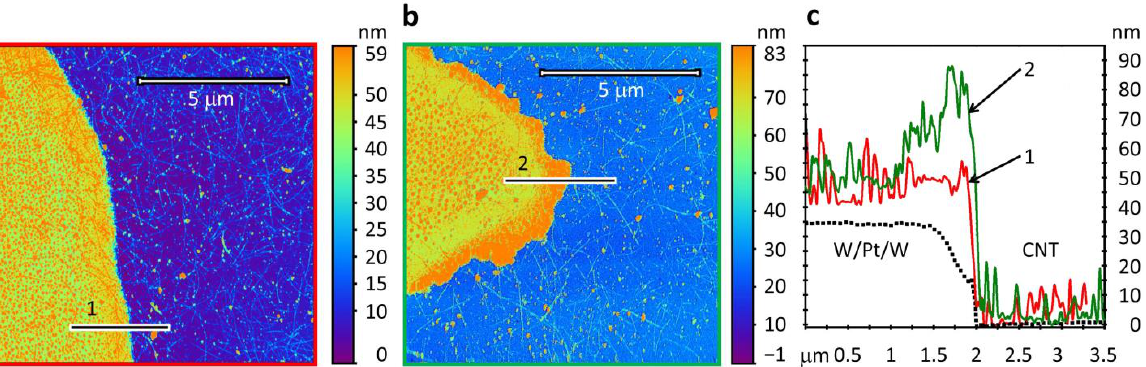
Figure 3. The exploring of sensor structures under study with atomic force microscopy: ( a ) AFM image of SWCNT-Pt structure (SWCNT50-Pt); ( b ) AFM image of SWCNT-WO 3 structure (SWCNT40-WO 3 ); ( c ) cross-sections of edge of initial metal W/Pt/W area and of “1”, “2” lines marked at 1a,b corresponding to profiles of SWCNT50-Pt and SWCNT40-WO 3 structures. sSWCNT50, sample. The appearance of WO 3 with crystalline structure was indexed by measuring the Raman spectra via recording the corresponding peaks at 265 cm −1 , 705 cm −1 , and 805 cm −1 [40,41], as shown in Figure 4a,b. Figure 4a gives an optical image of the sensor layer taken with ×100 microscope objective where the marked area has been considered for taking the Raman map. Still, it is worth noting that the peaks were observed at the thin WO 3 layer located on top of the Pt layer and were not registered at the thin WO 3 layer located on the glass surface. This is due to enhancing Raman scattering from the oxide located over Pt islands in frames of so-called the surface-enhanced Raman scattering (SERS) effect [42]. The island-like structure of the Pt layer is characterized by the specific resistivity value of ca. 0.5 kΩ/Sq., which is almost 30 times higher than the known data for the bulk Pt and